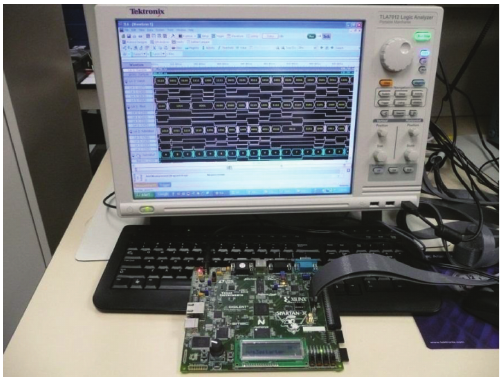
Figure 11: Test setup showing the Spartan 3E FPGA development board connected to a Tektronix TLA 7012 logic